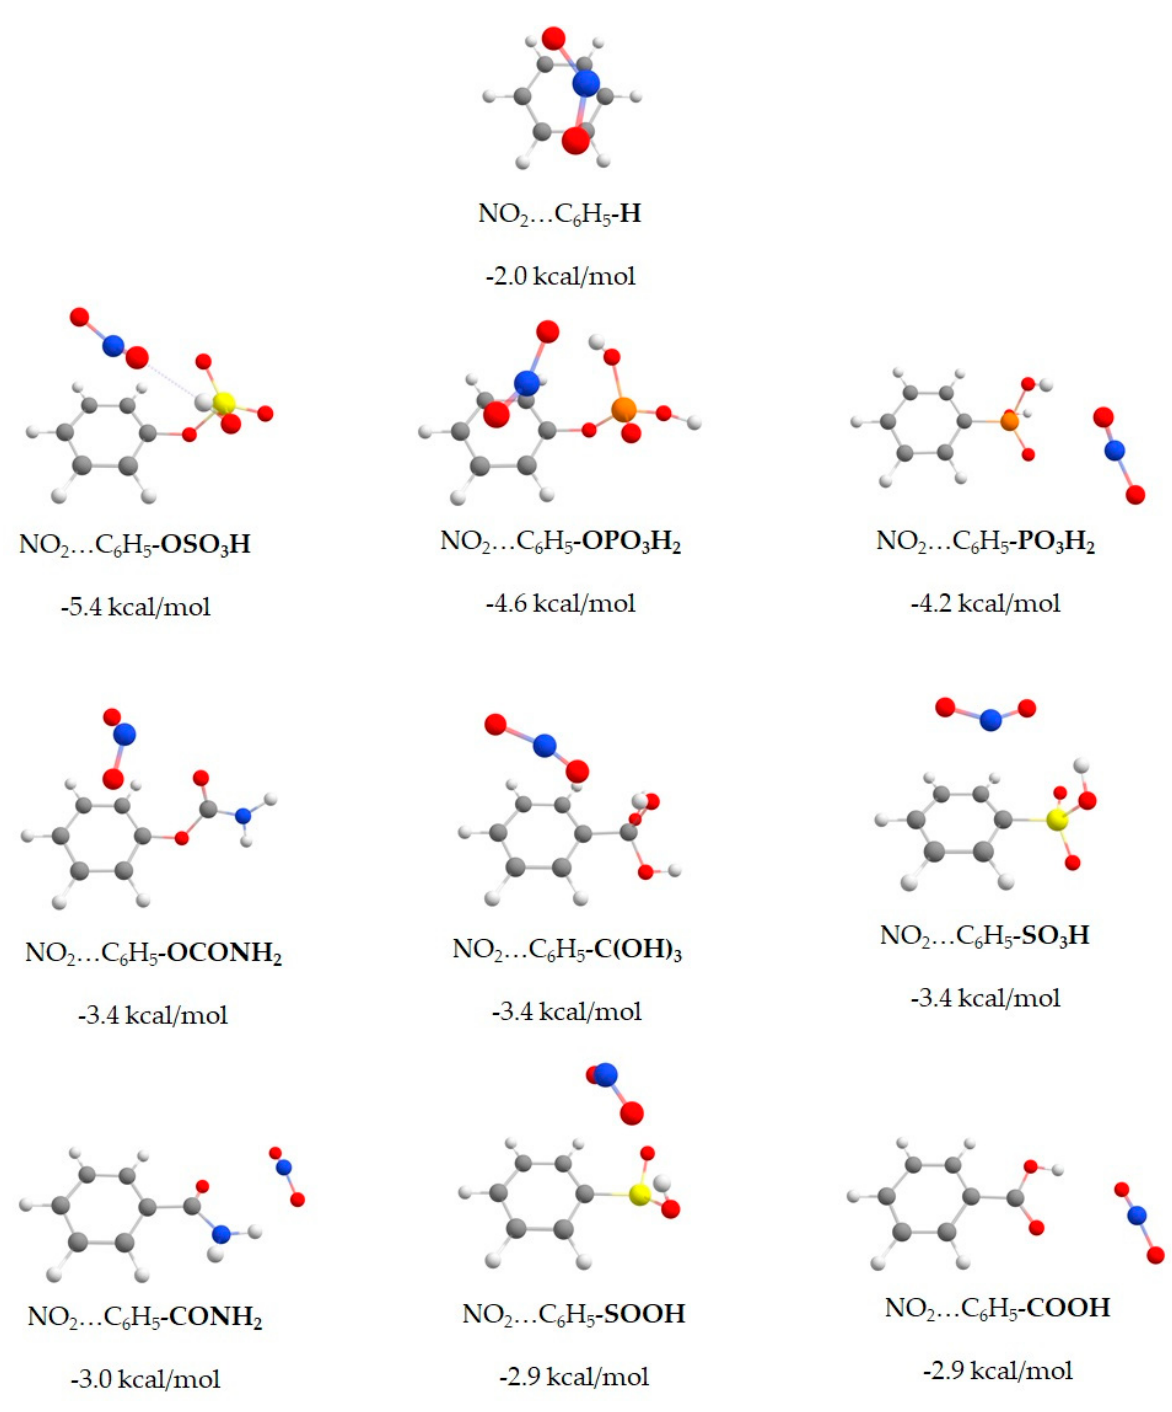
Figure 2. RI-DSD-BLYP D3(BJ) /def2-TZVPP optimized geometries of benzene and functionalized molecules interacting with NO 2 . Hydrogen, carbon, oxygen, nitrogen, lithium, sulfur, and phospho- rus atoms are depicted as white, gray, red, blue, purple, yellow, and orange spheres, respectively. The energetically most favorable structures are characterized by a weak interaction between NO 2 and organic linkers. More specifically, the acidic protons of the substituents, especially (-OSO 3 H, -OPO 3 H 2 , -PO 3 H 2 , -SOOH, -C(OH) 3 ), tend to interact with NO 2 ′ s oxy- gen site with binding distances between 1.89 Å and 2.22 Å. The trend in the best binding energies is also confirmed by the electron density redistribution plots in Figure 3. Due to the electrostatic nature of NO 2 ′ s interactions, these plots can serve as a rule of thumb for